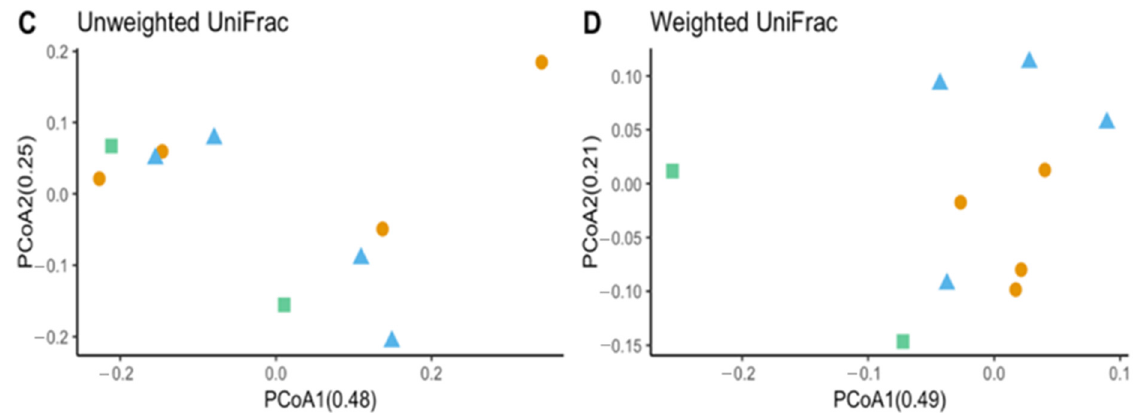
Figure 6. Beta diversity between laboratory-reared T. stercorea larva and adult gut microbiota com- position vs. field-collected adult. ( A ) Jaccard PCoA graph showing PCoA1 (0.48 variation) and PCoA2 (0.25 variation). ( B ) Bray–Curtis PCoA graph showing PCoA1 (0.56 variation) and PCoA2 (0.21 variation). ( C ) Unweighted UniFrac PCoA graph showing PCoA1 (0.48 variation) and PCoA2 (0.25 variation). ( D ) Weighted UniFrac PCoA graph showing PCoA1 (0.49 variation) and PCoA2 (0.21 variation). Blue triangles ( ▲ ) denote laboratory-reared larvae, orange circles ( ● ) denote laboratory-reared adults, and green squares ( ■ ) denote field-collected adults. Table 2. PERMANOVA analysis based on distance matrices between laboratory-reared larvae and adults of T. stercorea gut microbiota vs. field-collected adults.